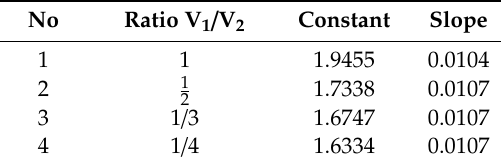
Table 1. Data of the linearity shift and the phase detector’s ratio of 2 signal amplitudes.